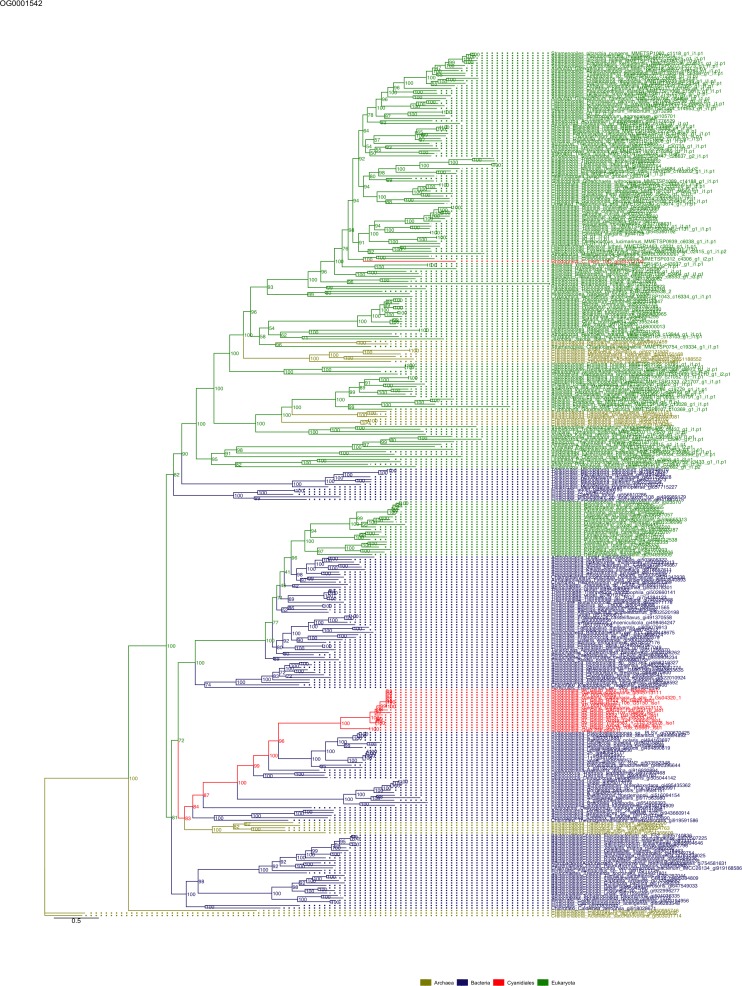
Sequence tree of orthogroup OG0001542.The tree is based on amino acid sequences. Archaea (yellow), Bacteria (blue), Cyanidiales (red), Eukaryotes including other red algae (green). Branches containing Cyanidiales sequences are highlited in red.